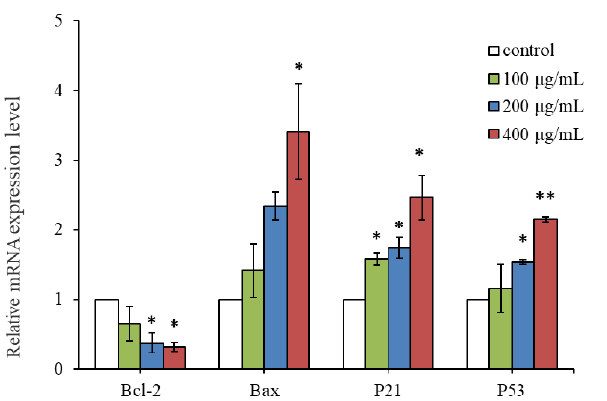
Figure 8. Effect of RLE on expression of cell cycle and apoptosis-associated genes on HT-29 cells (`x ± SD, n = 3). * p < 0.05 ** p < 0.01 vs. control